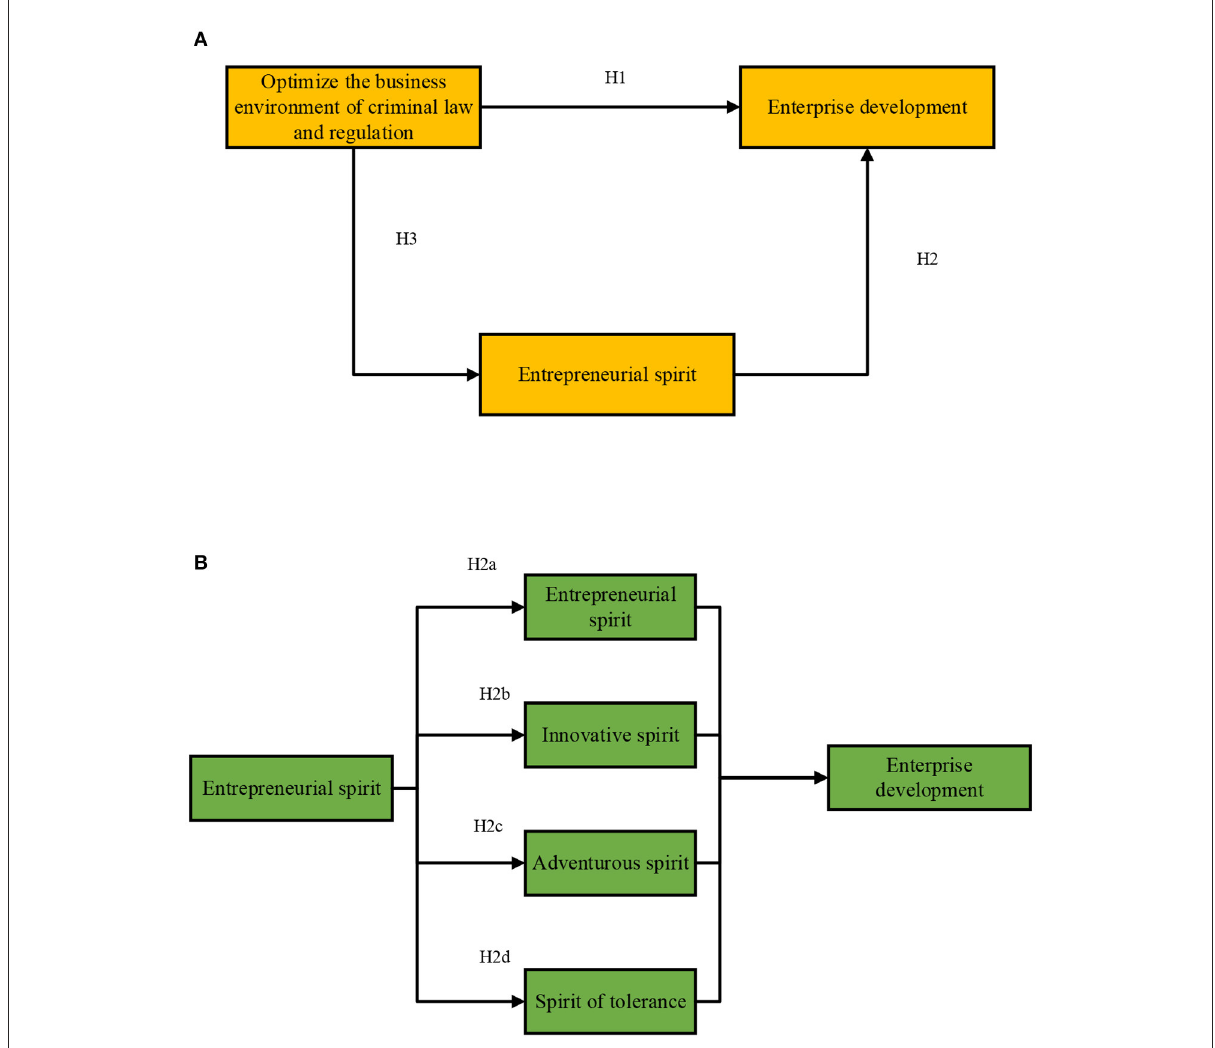
FIGURE3 The conceptual model of CLR-based business environment optimization, ES, and ED. (A) The overall conceptual model diagram; (B) the conceptual model of ES and